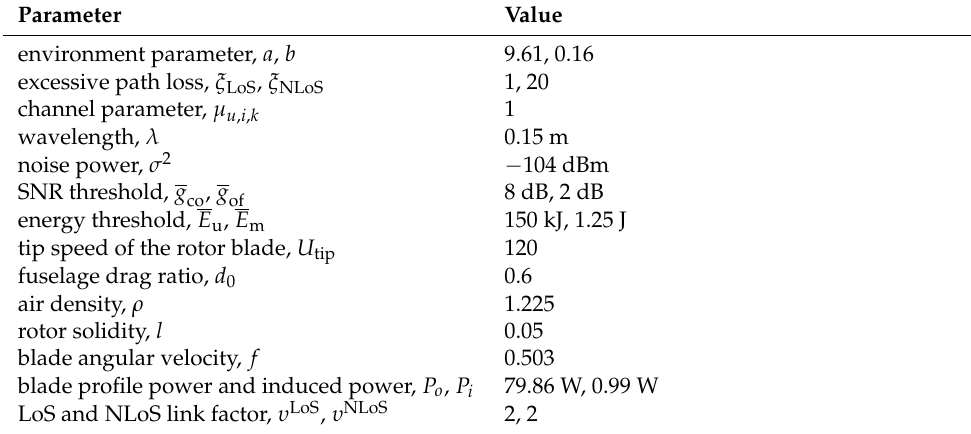
Table 2. Simulation